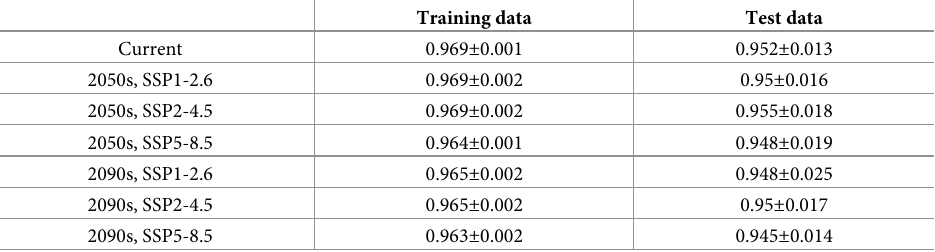
Table 1. AUC values of